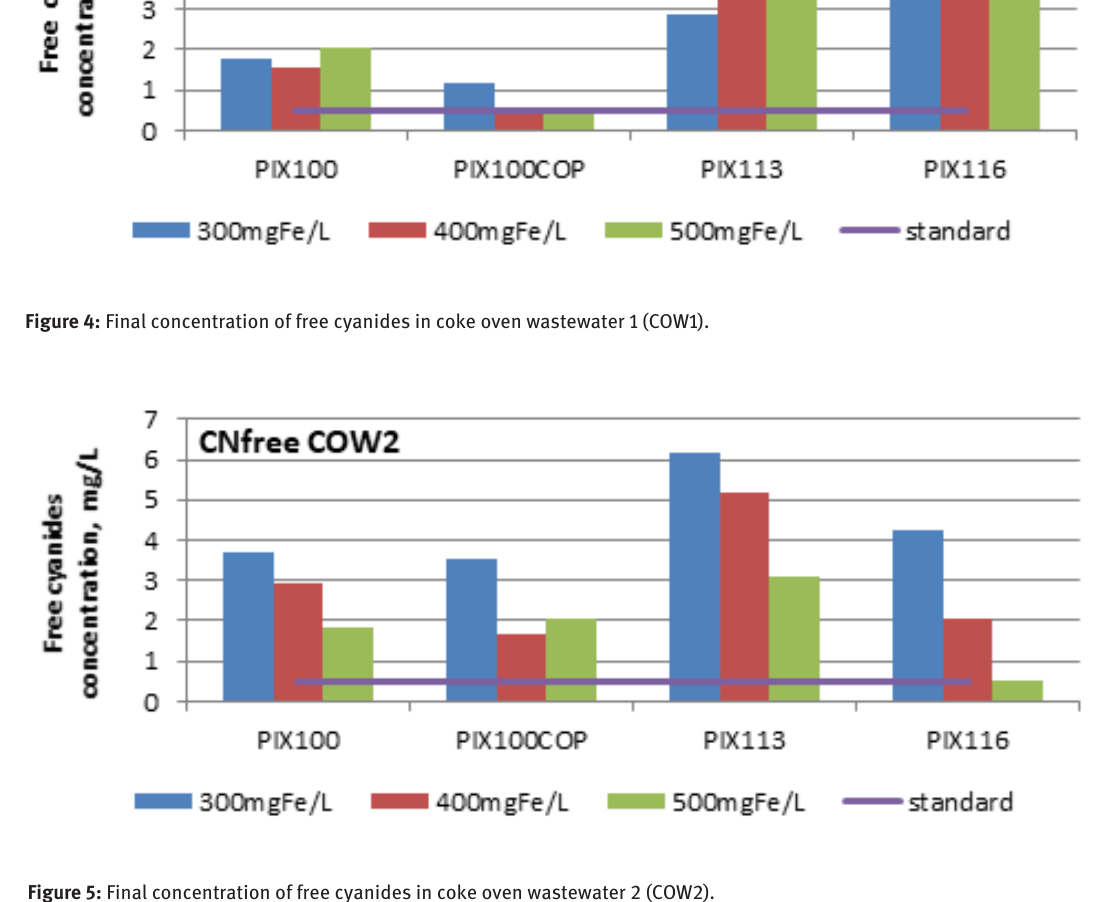
Figure 5: Final concentration of free cyanides in coke oven wastewater 2 (COW2).